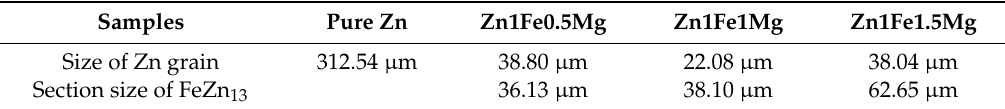
Table 2. Grain sizes of alloys and FeZn13 phase size of alloy